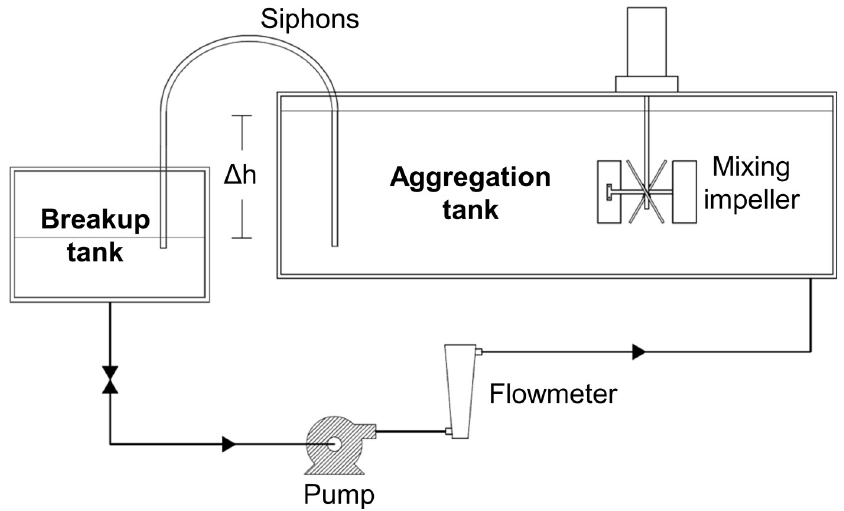
Fig 1. Schematic diagram of the floc breakup facility.